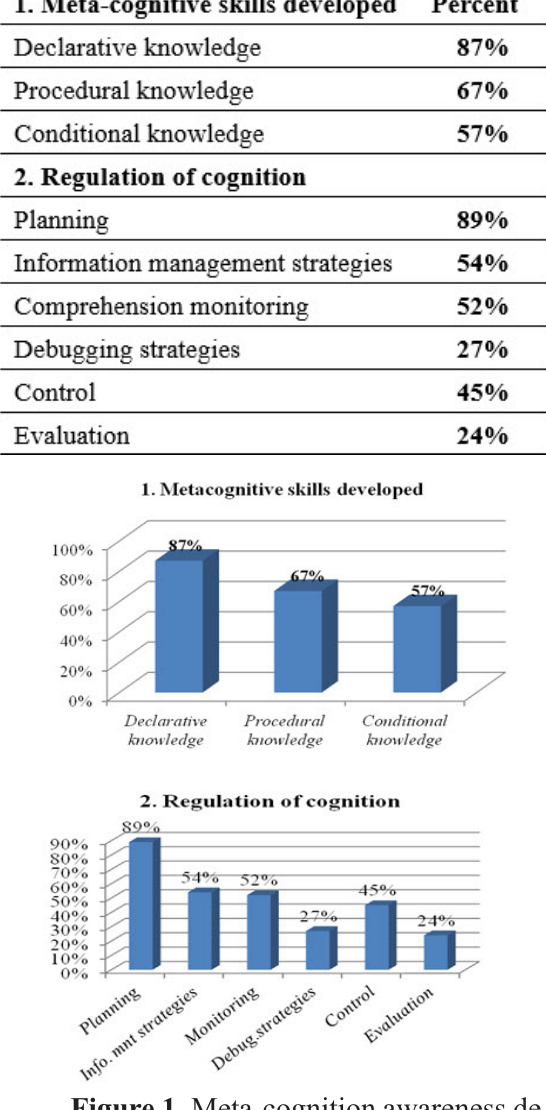
Figure 1. Meta-cognition awareness de- velopment (at the beginning of the experimen- tal learning) Table 2. Meta-cognition awareness de- velopment (at the end of the experimental